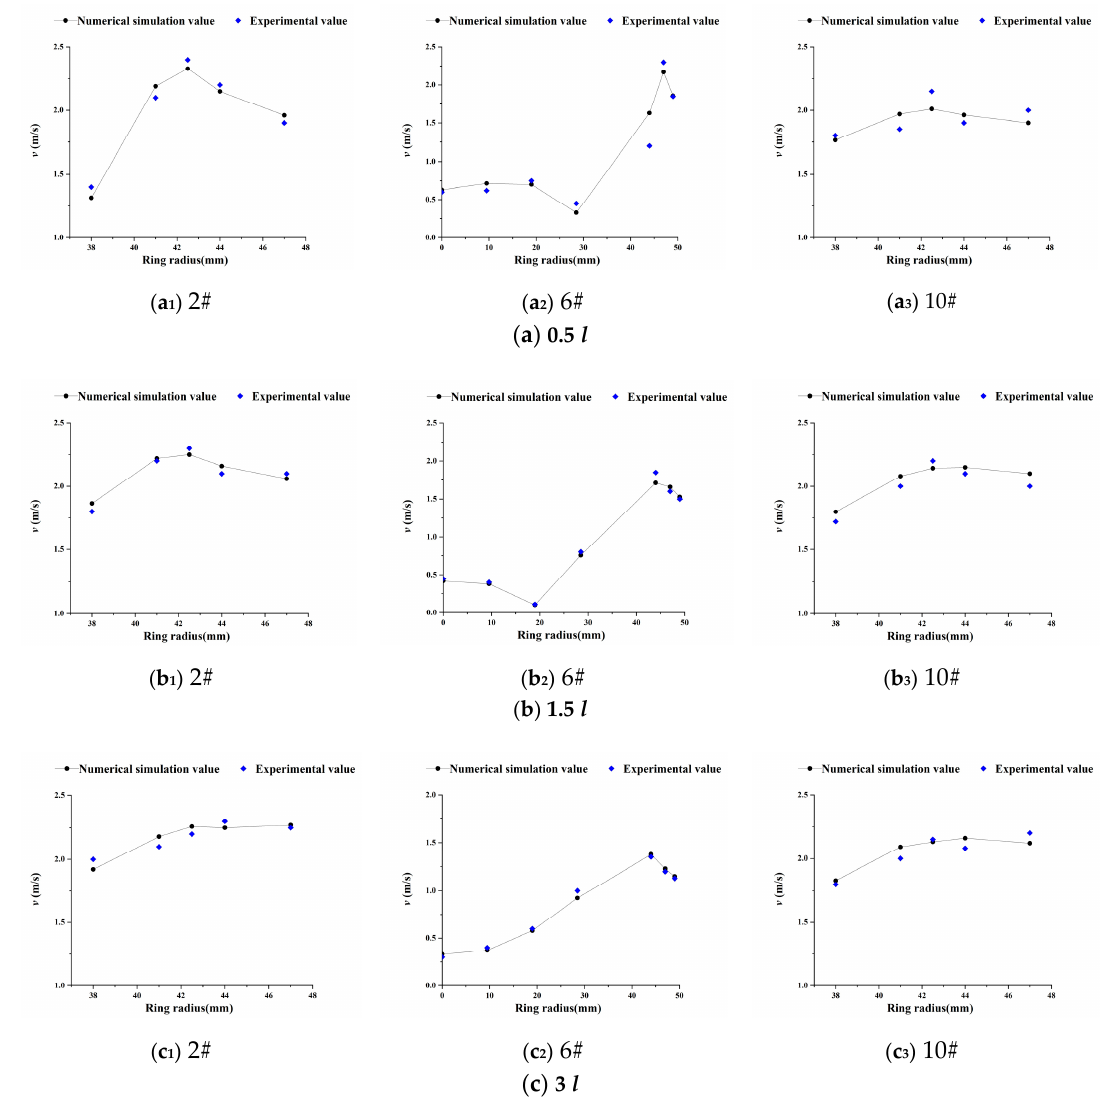
Figure 17. Comparison of experimental value and numerical simulation value on the velocity magnitude. ( a ) L = 0.5 l . ( b ) L = 1.5 l . ( c ) L = 3 l . Note: 2# represents the middle cross-section of the left pipe vehicle, 6# represents the cross-section in the middle of the spacing and 10# represents the middle cross-section of the right pipe vehicle.